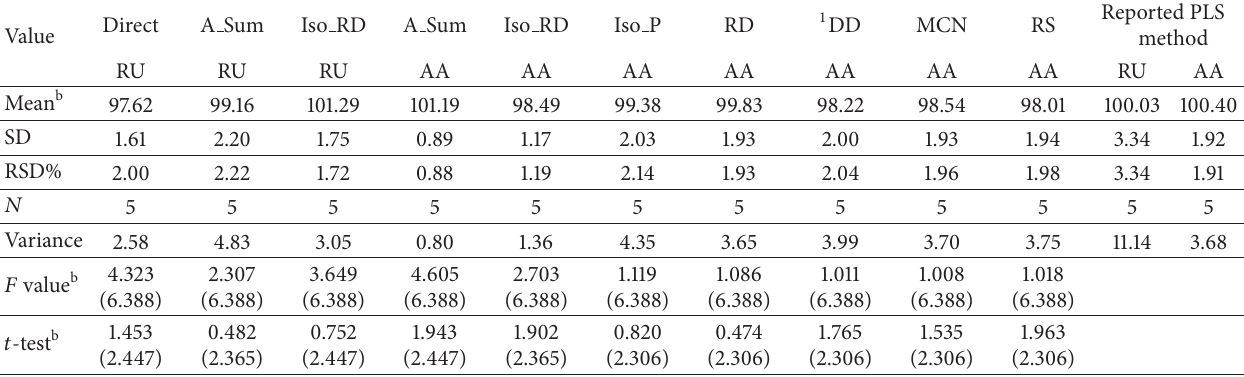
Table 3: Statistical comparison for the results obtained by the proposed spectrophotometric methods and the reported method [11] a for the analysis of AA and RU (Ruta C 60) batch number 1210864.